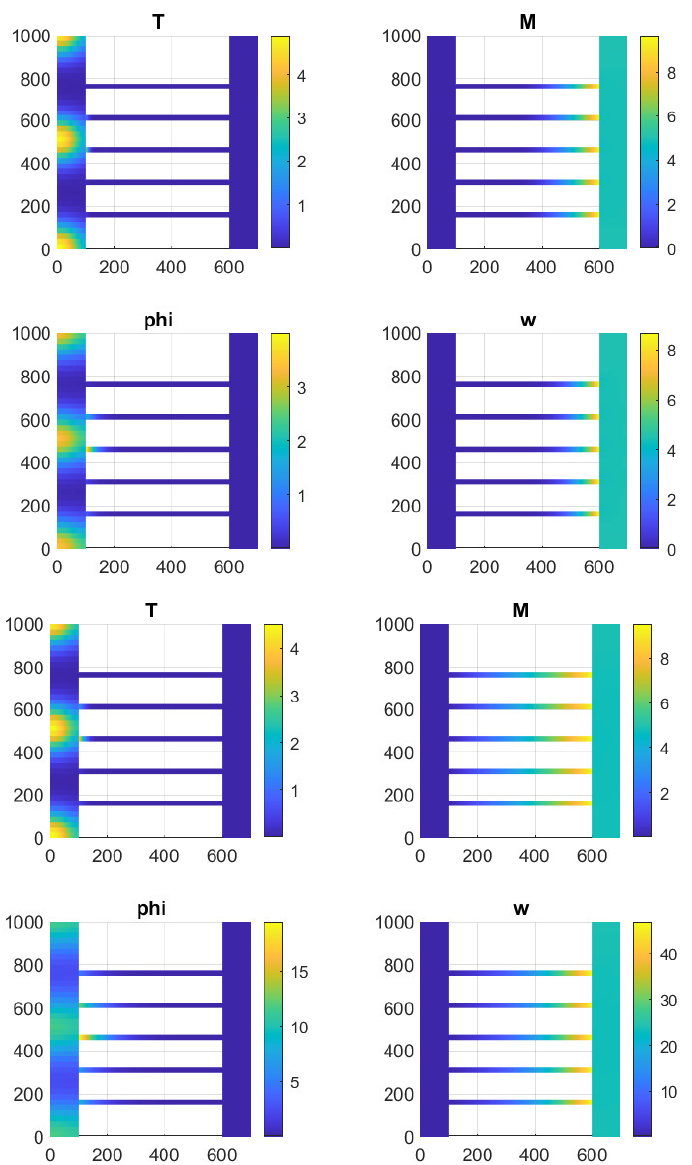
Figure 9. Treated case. Evolution of the model (3)–(7) at time t = 10,000 s ( top ) and at time t = 50,000 s ( bottom